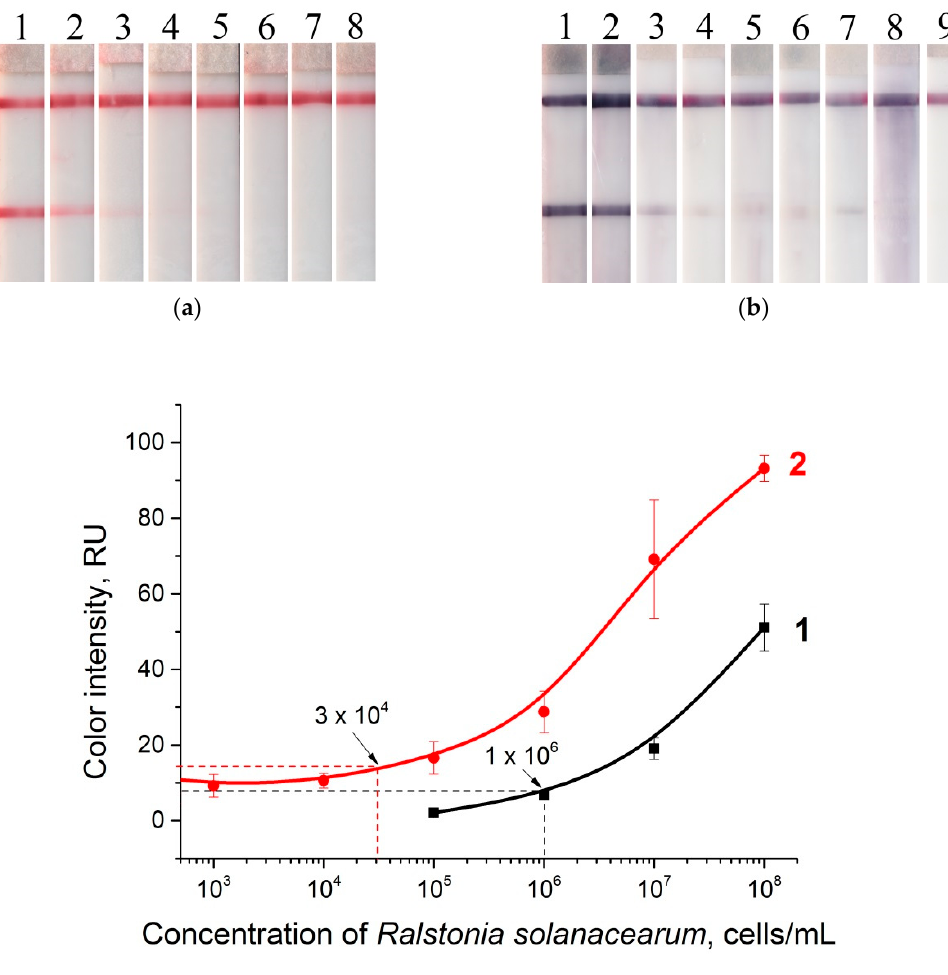
Figure 7. LFIA in potato tuber extract: ( a ) strips after testing and before enlargement; ( b ) strips after testing and enlargement. Strips #1–8 correspond to 10 8 , 10 7 , 10 6 , 10 5 , 10 4 , 10 3 , 10 2 , and 10 1 cells ∙ mL − 1 of R. solanacearum , respectively, and strip #9 corresponds to a negative control (0 cells ∙ mL − 1 ); ( c ) calibration curves of LFIA of R. solanacearum before (1) and after (2) enlargement.